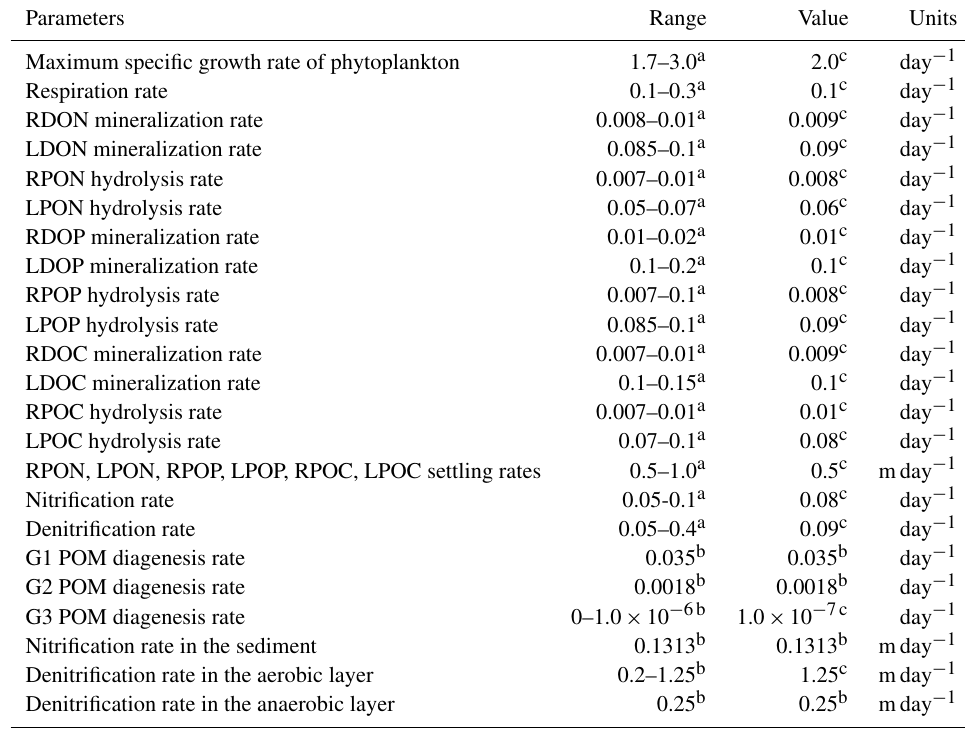
Table 2. Parameters for the water quality model